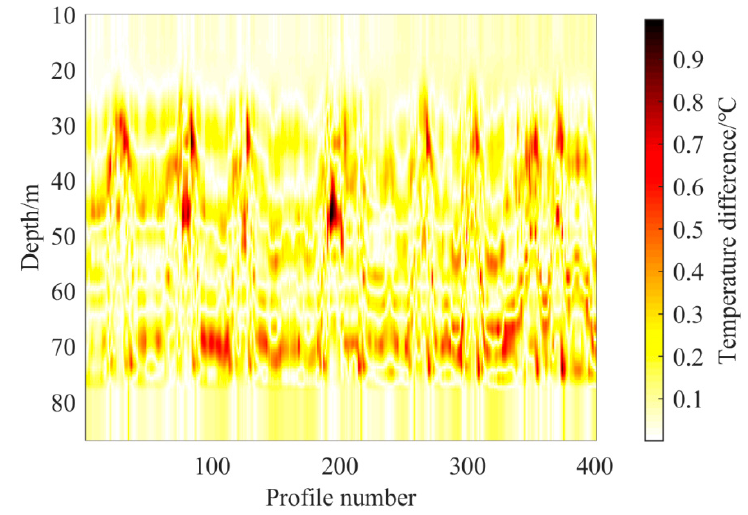
Figure 12. The RMSE of inversion temperature profiles by temperatures at depths of 50, 56 m and 63 m.